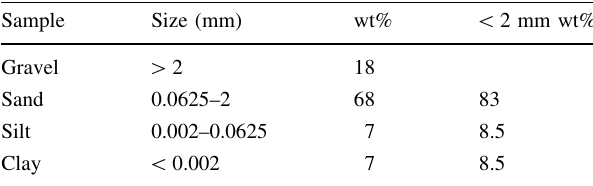
Table 1 Particle size distribution of the sampled soil